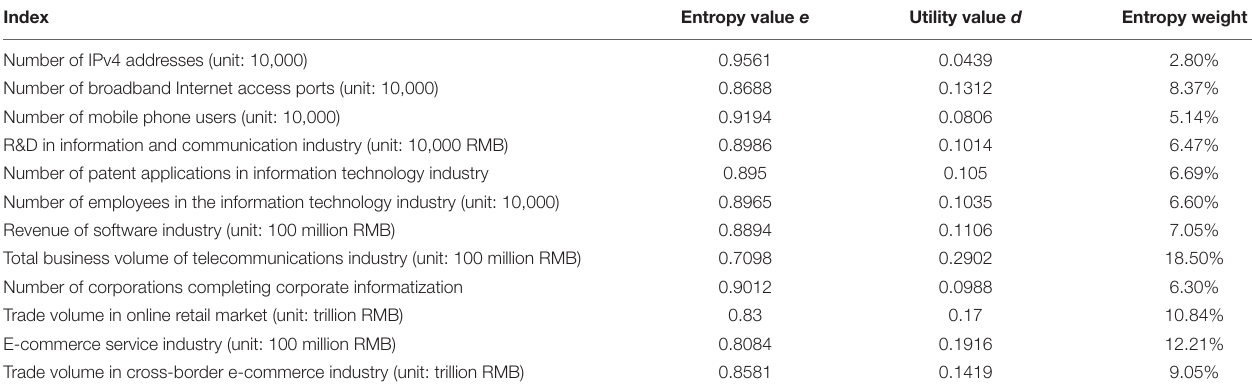
TABLE 4 | Entropy weights obtained through entropy weight method.